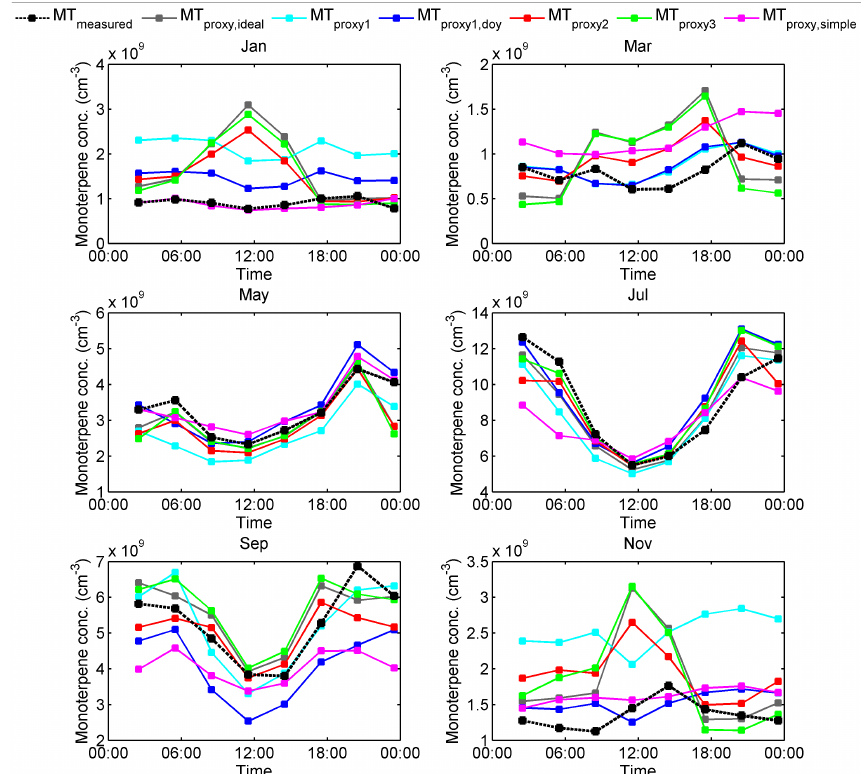
Figure 7. Median diurnal variation of the measured monoterpenes and different proxies in different months (the rest of the months are shown in Fig. A1). The black circles show the measured concentration, the gray squares MT proxy , ideal , the light blue squares MT proxy1 , the dark blue squares MT proxy1 , doy , the red squares MT proxy2 , the green squares MT proxy3 and the magenta squares MT proxy , simple . Note that the scales of the y axis are not the same in all the